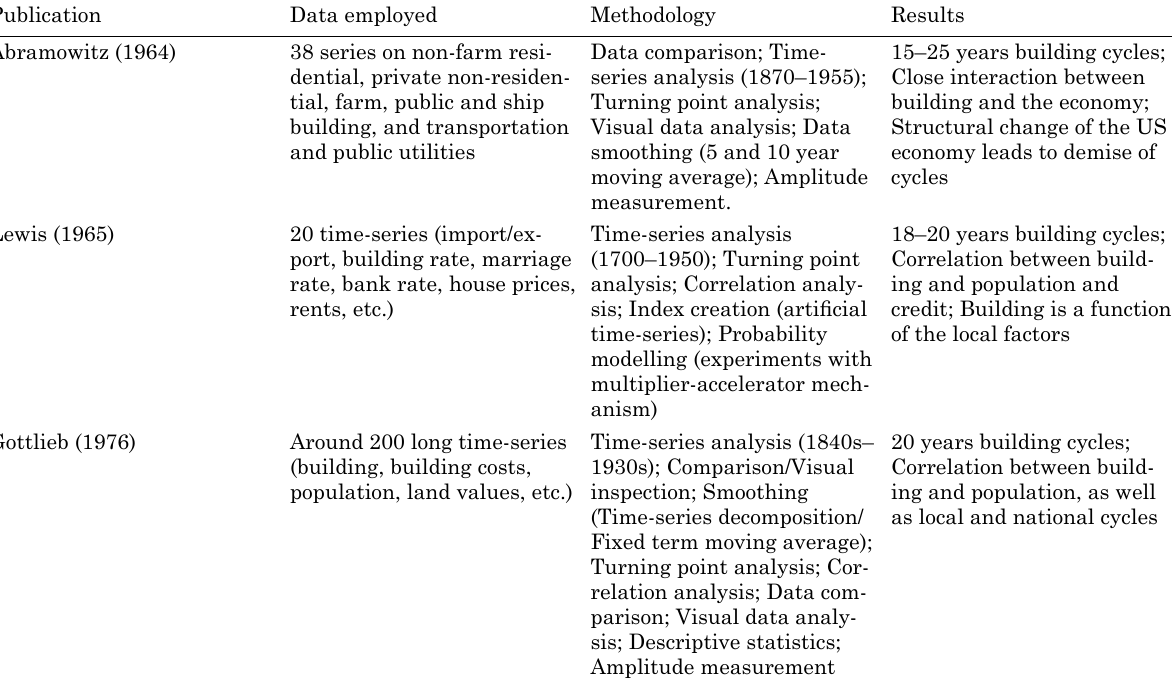
table 2. Key post-war publications on property